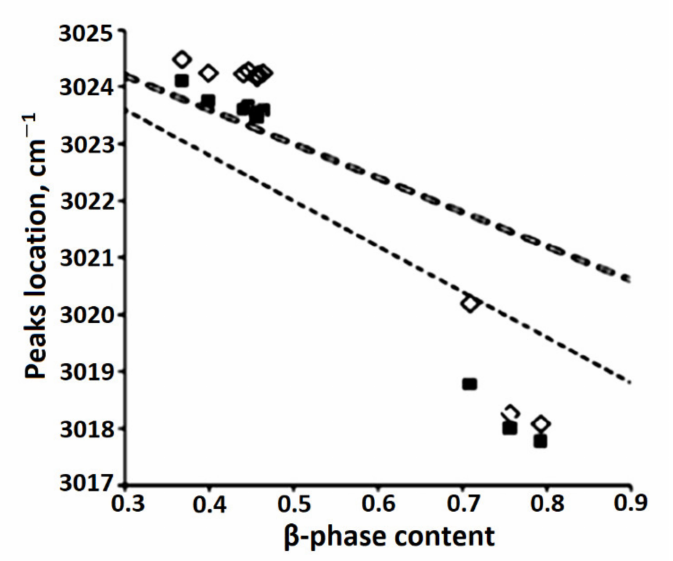
Figure 8. Dependence of the frequency position of peaks 1 and 2 on the concentration of the β -phase in the model and experimental IR spectra [26].